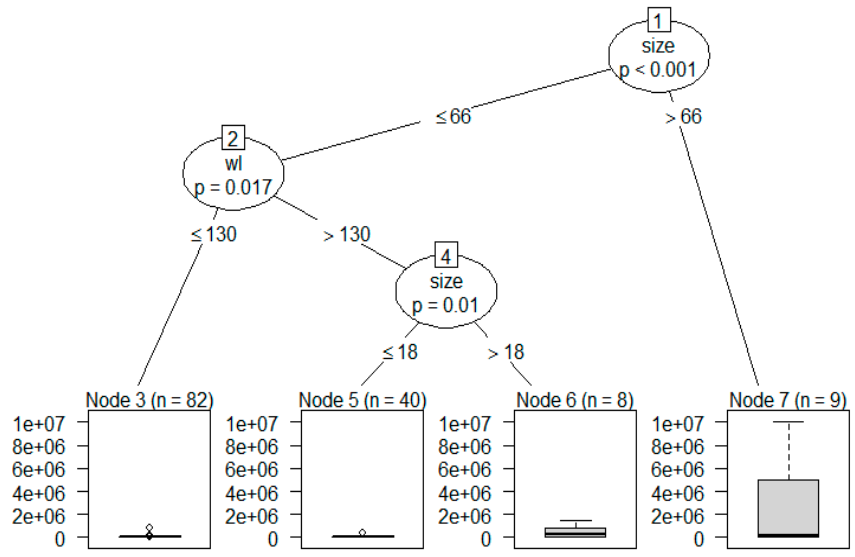
Figure 2. Exemplary representation of a single tree of a random forest for concept visualization, with the response variable business interruption costs in Euro.